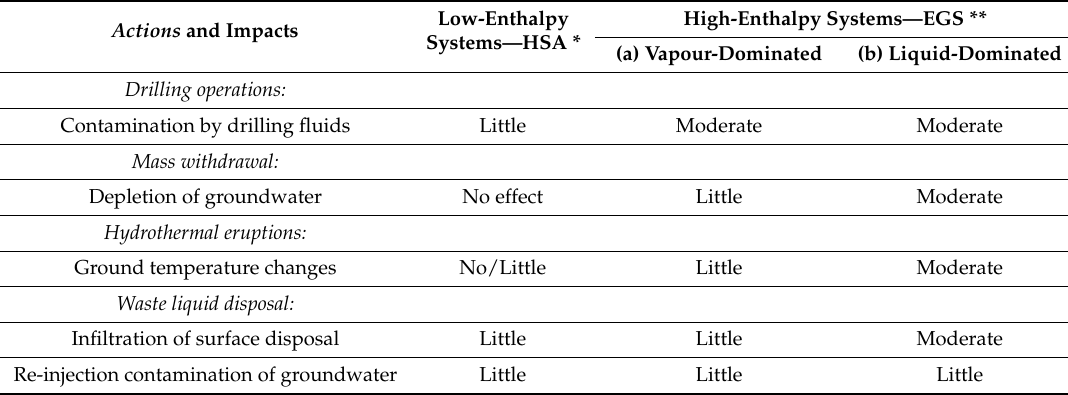
Table 2. Potential effects of geothermal energy development on groundwater (adapted from